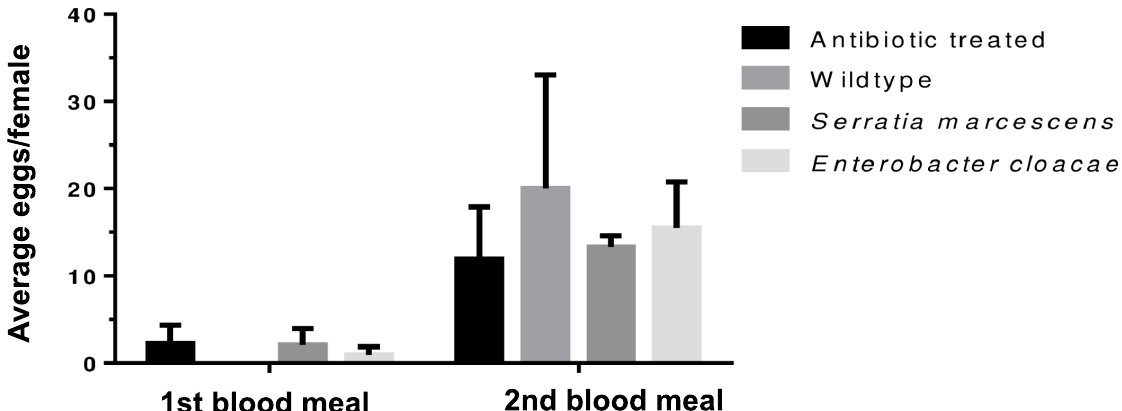
Fig 2. Mean number of eggs laid by Anopheles gambiae s.l. following antibiotic treatment and reintroduction of E . cloacae and S . marcescens . Error bars show the standard error of mean.